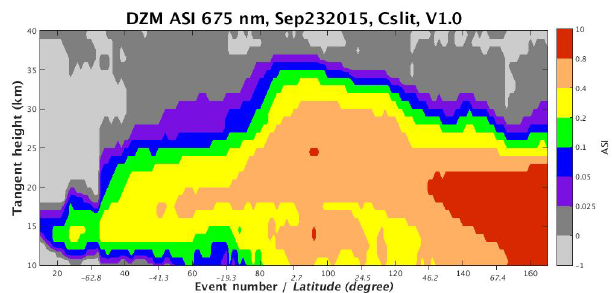
Figure 16. Daily zonal mean aerosol scattering index (ASI, or y ) measured by the SNPP OMPS LP instrument. This picture corre- sponds to center slit observations on 23 September 2015. The x axis is labeled with both the event number (solid) and tangent point lat- itude (italics). The color scale is nonlinear, designed to highlight relatively small y values in the